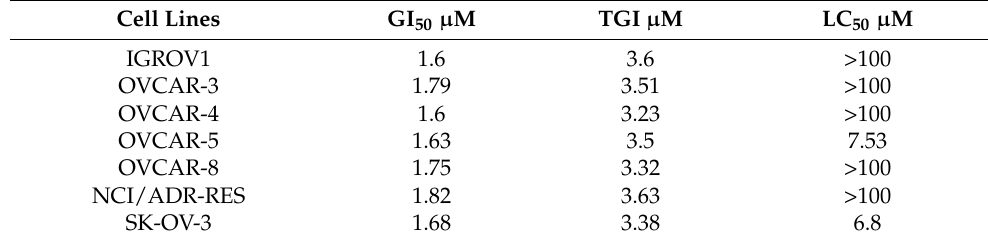
Figure 6. NSC777201 met the required criteria of drug-likeness. ( A ) Schematic representation of the structure of NSC777201. ( B ) Bioavailability radar presenting suitable physicochemical spaces of the oral bioavailability of NSC777201. The optimal range of each property is presented in the pink area. ( C ) BOILED-Egg model of the brain or intestinal estimated permeation of NSC777201. ( D ) Pie chart presents the repartition of protein classes of potential druggable candidates for NSC777201. ( E ) Antiproliferative effects of NSC777201 against the panel of NCI ovarian cancer cell lines. A single dose of 10 µM of NSC777201 was used to treat each cell line. The zero point denotes the mean percentage of cell growth. Each cell line’s percentage growth inhibition relative to the mean is represented by values under 100, and values below zero indicate cell death. ( F ) Dose-dependent cytotoxic response curves of NSC777201 against the panel of NCI’s ovarian cancer cell lines. The growth of untreated cells as the growth percentage value of +100 is presented on the Y -axis. Table 2. Cytotoxic and anti-proliferative activities of NSC777201 against NCI’s ovarian cancer cell